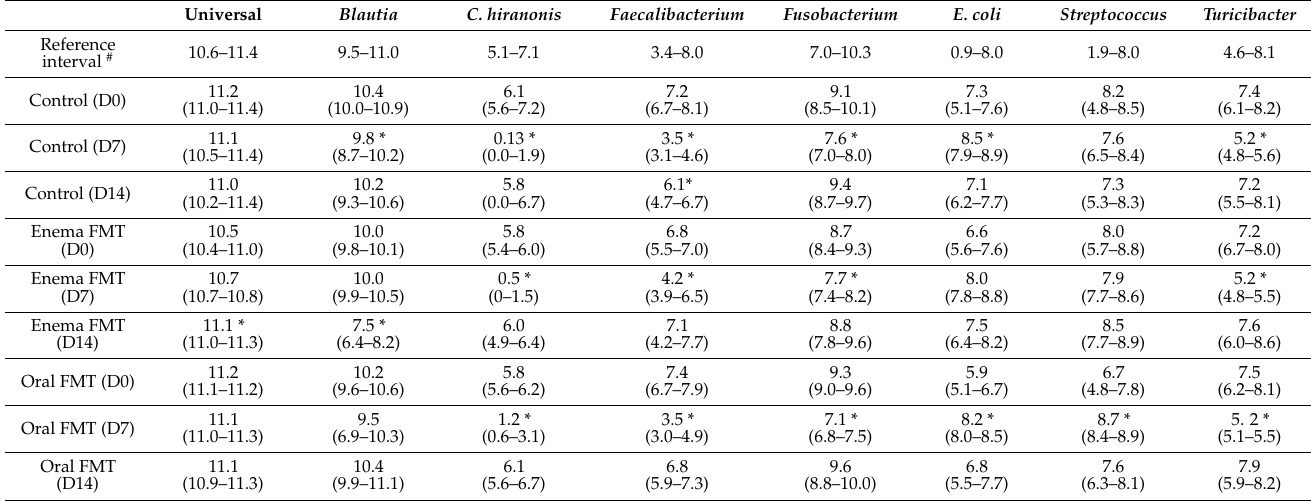
Table 1. Results of qPCR analysis of 7 bacterial taxa in the feces at baseline (D0), end of tylosin treatment (D7) and 1 week after tylosin discontinuation (D14).